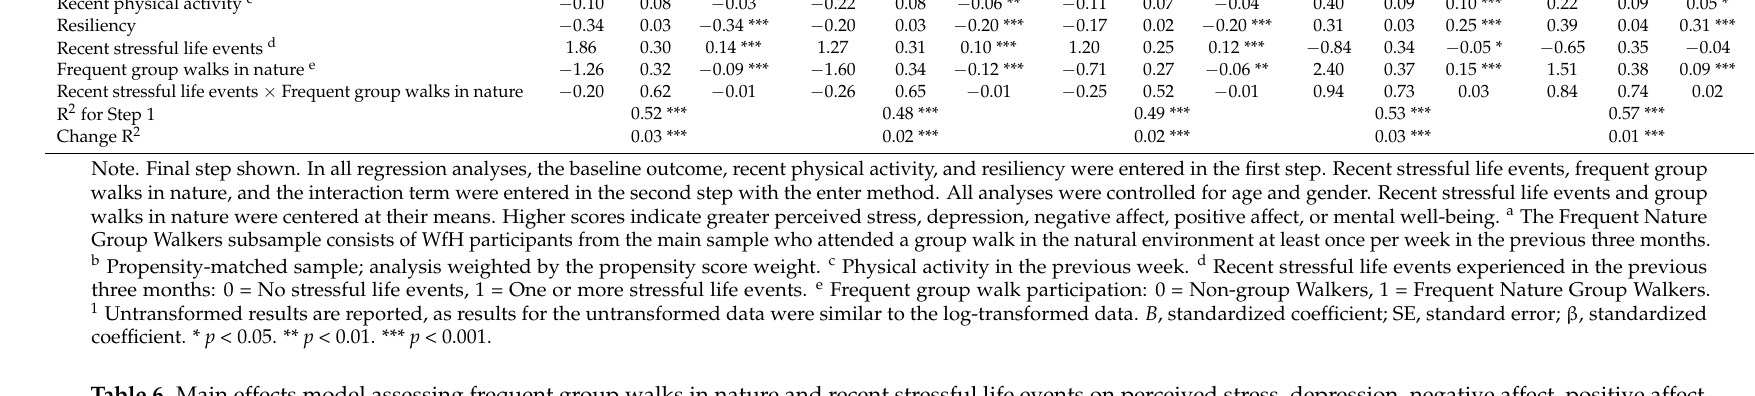
Table 6. Main effects model assessing frequent group walks in nature and recent stressful life events on perceived stress, depression, negative affect, positive affect, and mental well-being. Frequent Nature Group Walkers Subsample a ( n = 930 b